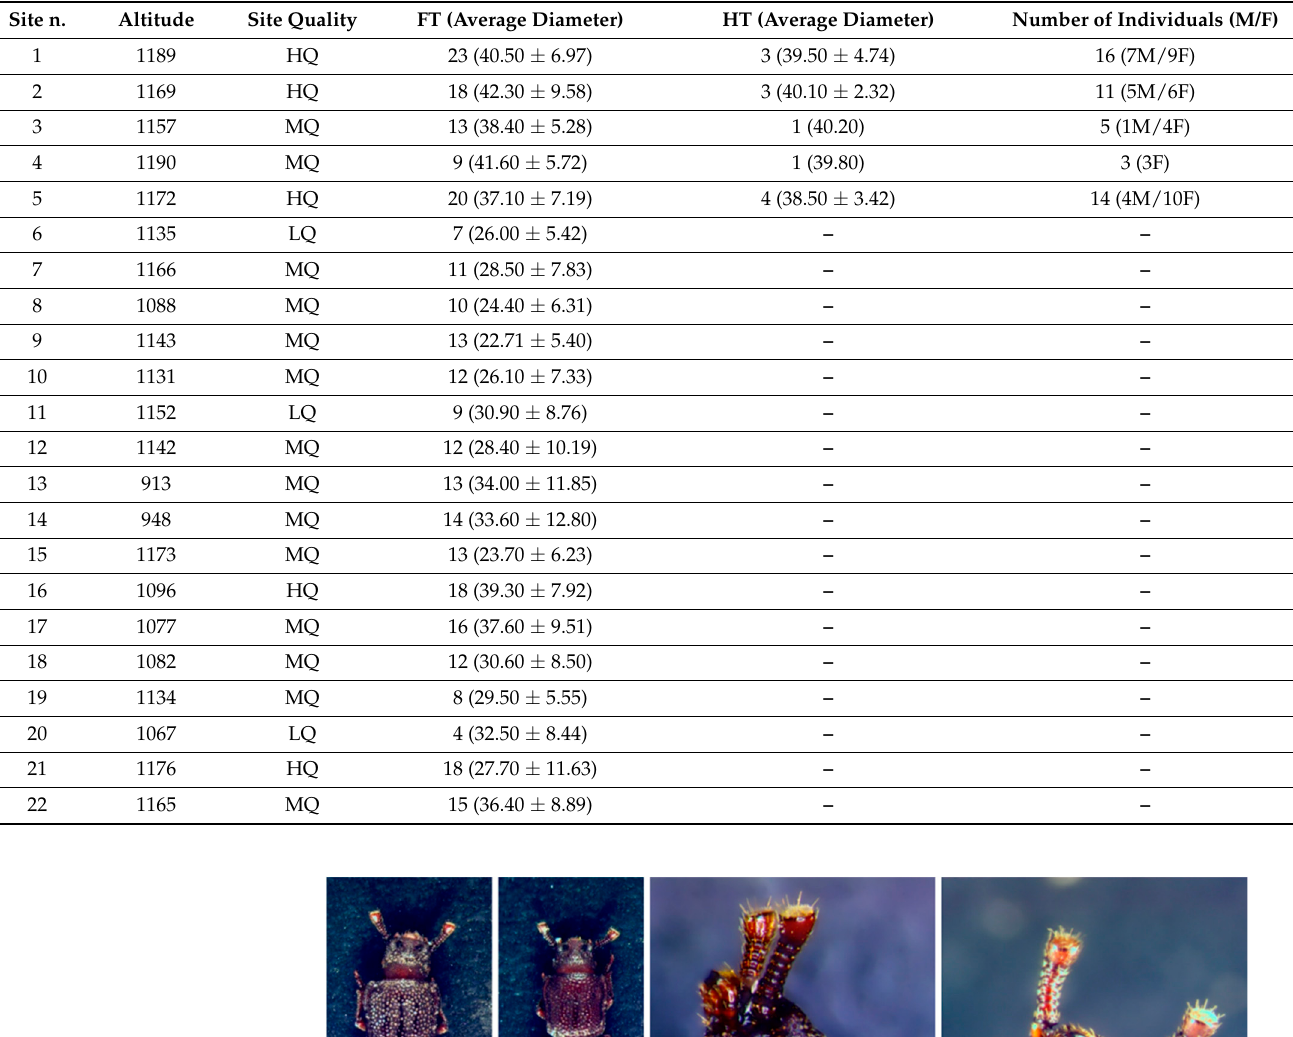
Table 1. Characteristics of the 22 sampling sites in Riserva Naturale Biogenetica Marchesale: site number (Site n.), altitude (m a.s.l.), site quality, number of fallen trunks (FT) and average diameter (cm) ± standard deviation (SD), number of host fallen trunks (HT) and average diameter (cm) ± SD, and number of individuals of P. italicus found (male or female, M/F). HQ, high-quality forest biotope; MQ, medium-quality forest biotope; and LQ, low-quality forest biotope. According to the model by Mazzei et al. [23] and according to the general criteria for